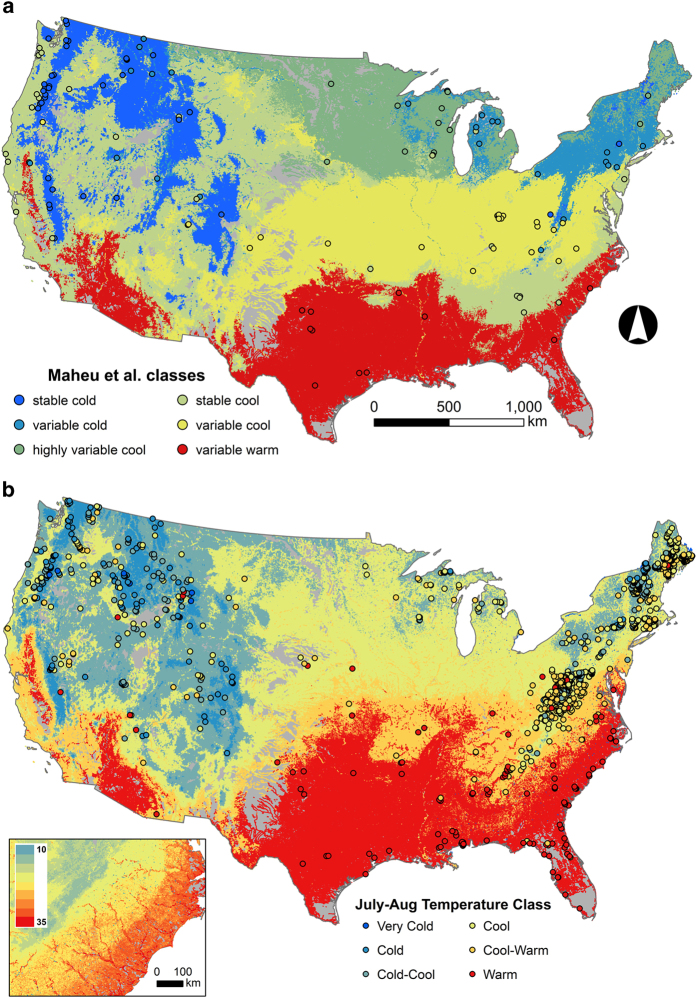
Temperature classes within stream reaches of the conterminous US.Temperature classes were mapped to stream reaches using (a) Maheu et al.3 thermal regime classes developed for stream gages (points), and (b) average July–August temperature values taken from multiple datasets (points). Inset in panel b shows the level of detail within continuous values of July–August temperature (°C) underlying the classification.